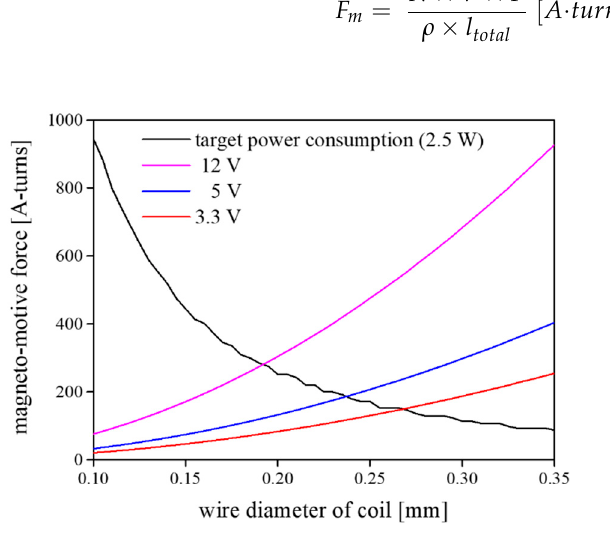
Figure 6. Simulation result of the magneto-motive force as a function of wire diameter.